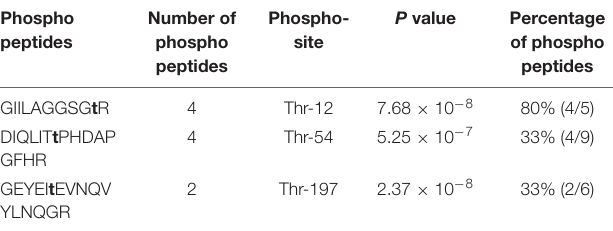
TABLE 1 | Phosphorylation sites of RmlA by PknB identified with mass spectrometry. Phospho Number of peptides phospho